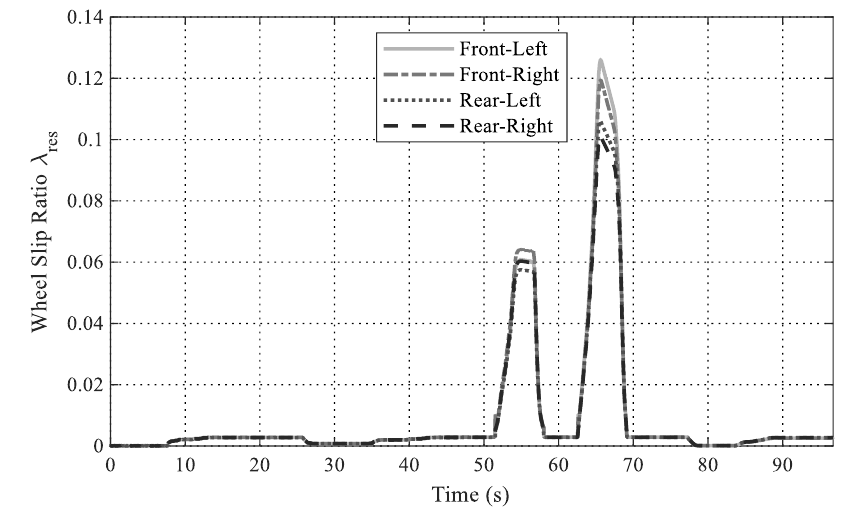
Figure 14. Slip-ratio at Wheels for Scenario